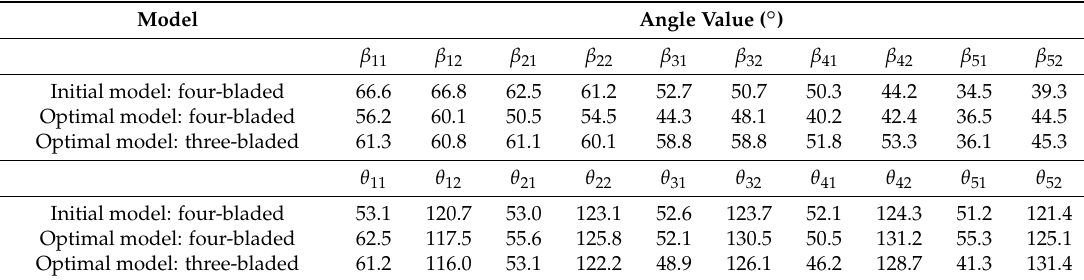
Table 2. Angles in initial and optimal conditions.